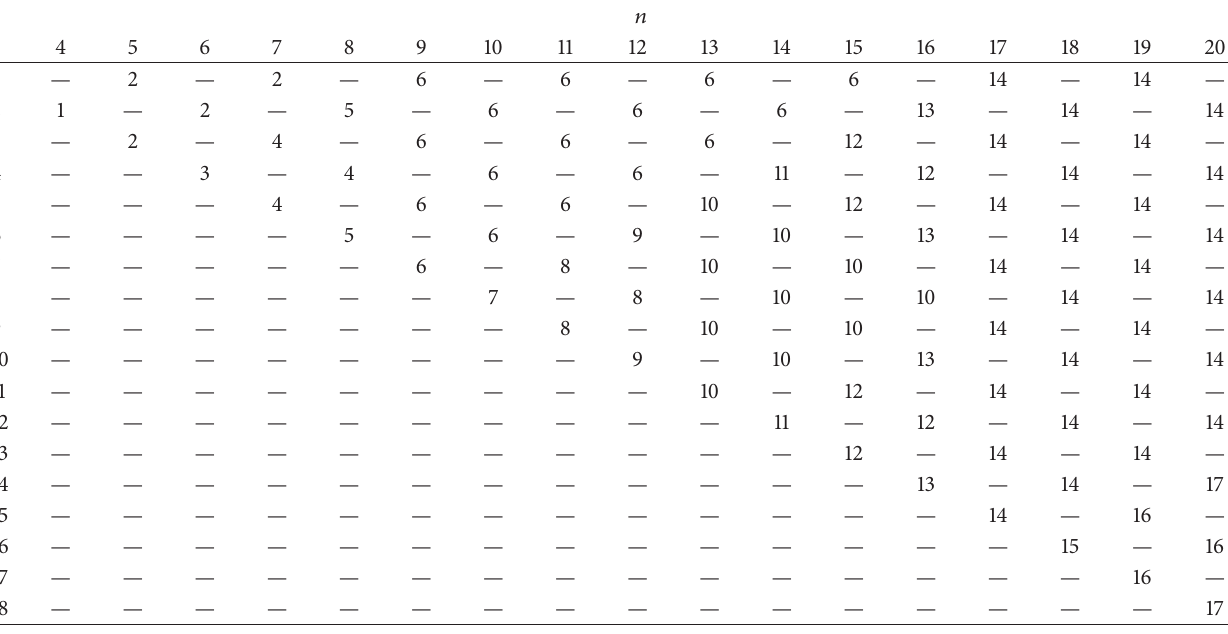
Table 1: ℎ(𝑛,𝑟) for 4 ≤ 𝑛 ≤ 20 .